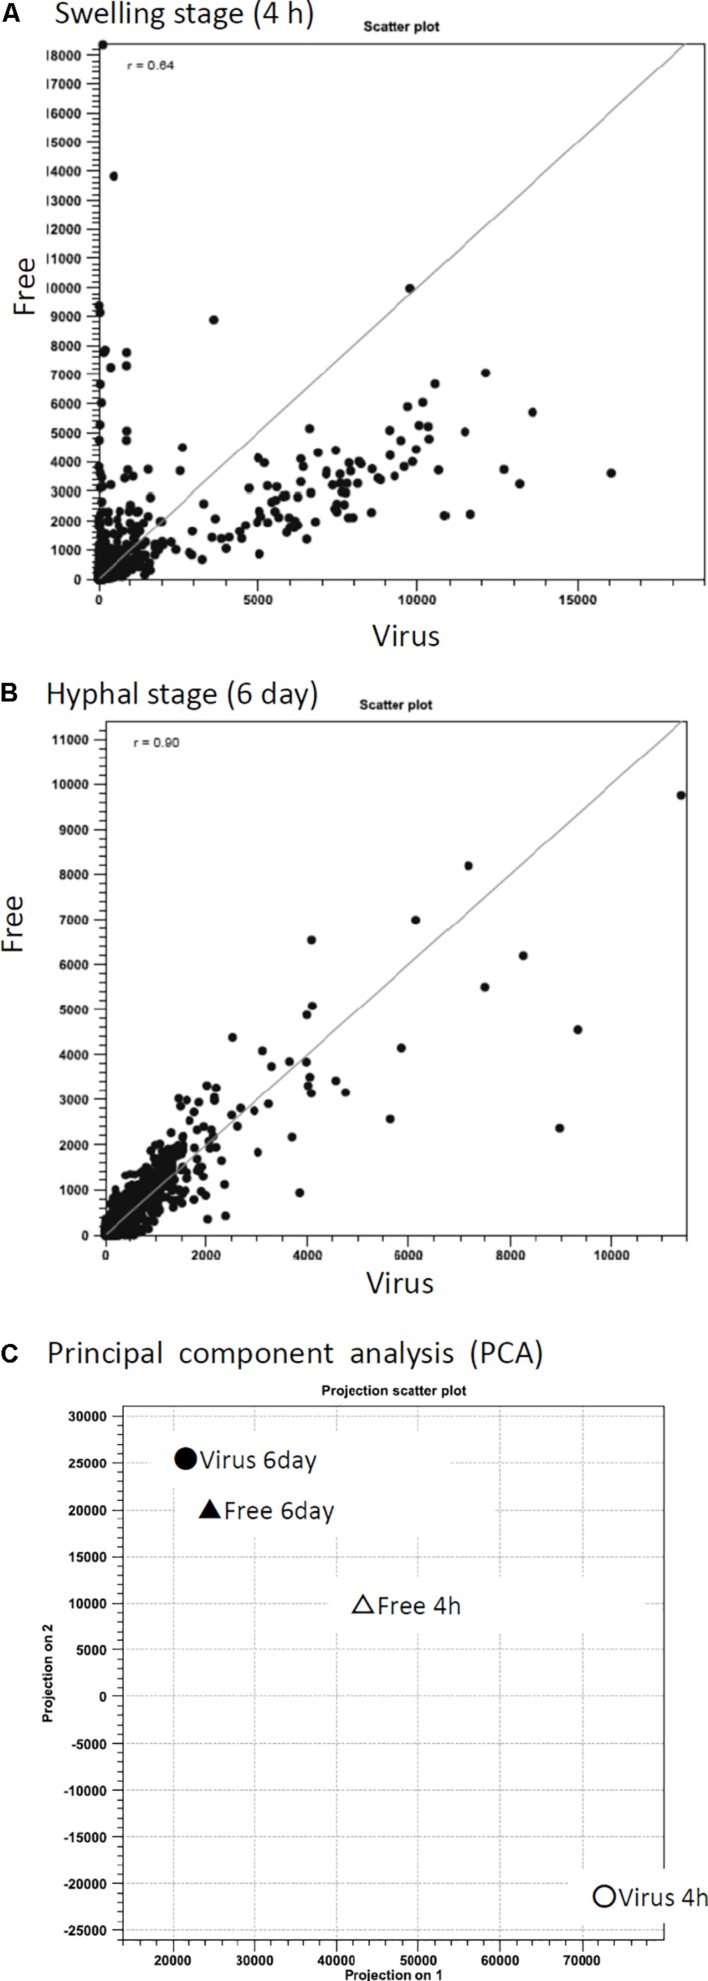
Correlation of differential gene expression between virus-infected (Virus) and virus-free (Free) strains analyzed by RNA-seq. (A,B) Scatter plots of transcript levels (RPKMs) at the swelling stage (A: 4 h) and the hyphal stage (B: day 6). (C) Transition of gene expression patterns in the virus-infected (circle symbols) and virus-free (triangle) strains during swelling stage (4 h, white) and hyphal stage (day 6, black). The pattern was examined through principal component analysis (PCA).